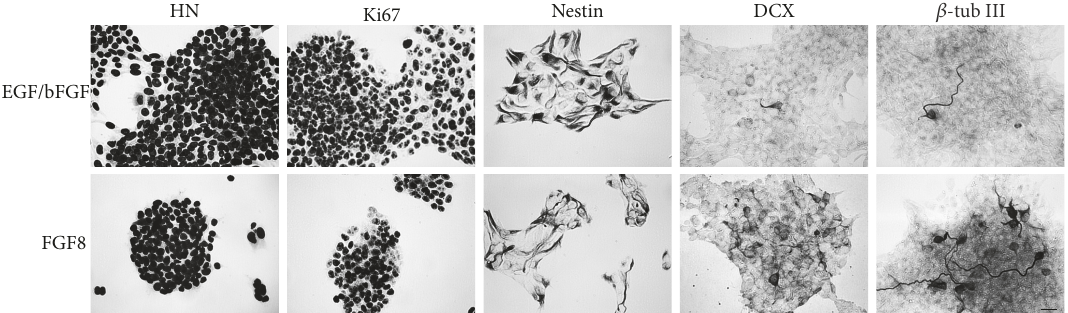
Figure 5: Immunocytochemical characterization of proliferating human midbrain-derived stem cells. Immunostaining of cells during, (1) standard propagation (upper panel) in a medium with epidermal growth factor (EGF) and basic fi broblast growth factor (bFGF) and (2) after removal of EGF/bFGF and one-day exposure to fi broblast growth factor 8 (FGF8) (lower panel), which represents the initial step of the induced neuronal di ff erentiation (sequential addition of various factors, see Materials and Methods for details). To visualize all cells, cultures were immunostained using an antibody against human nuclei (HN). Almost all cells in both experimental groups expressed Ki67, a marker of dividing cells. Moreover, a very large proportion of the cells expressed the intermediate fi lament protein nestin, a marker of neural progenitor cells. Only very few cells had spontaneously di ff erentiated into β -tubulin III- ( β -tub III-) positive or doublecortin- (DCX-) positive immature neurons in the EGF/bFGF group, whereas some β -tub III-positive and DCX-positive neuronal cells were seen after short-term FGF8 treatment. Scale bar =20 μ